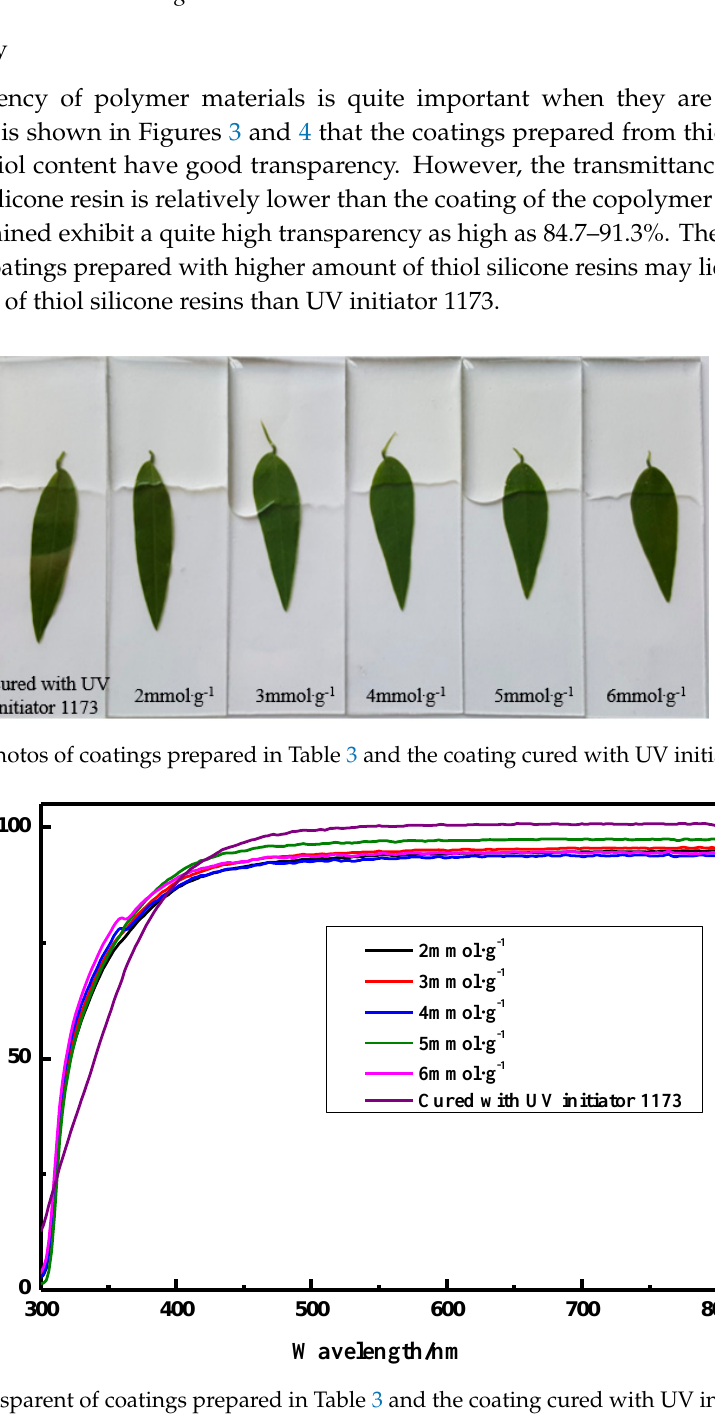
Figure 4. Transparent of coatings prepared in Table 3 and the coating cured with UV initiator 1173.